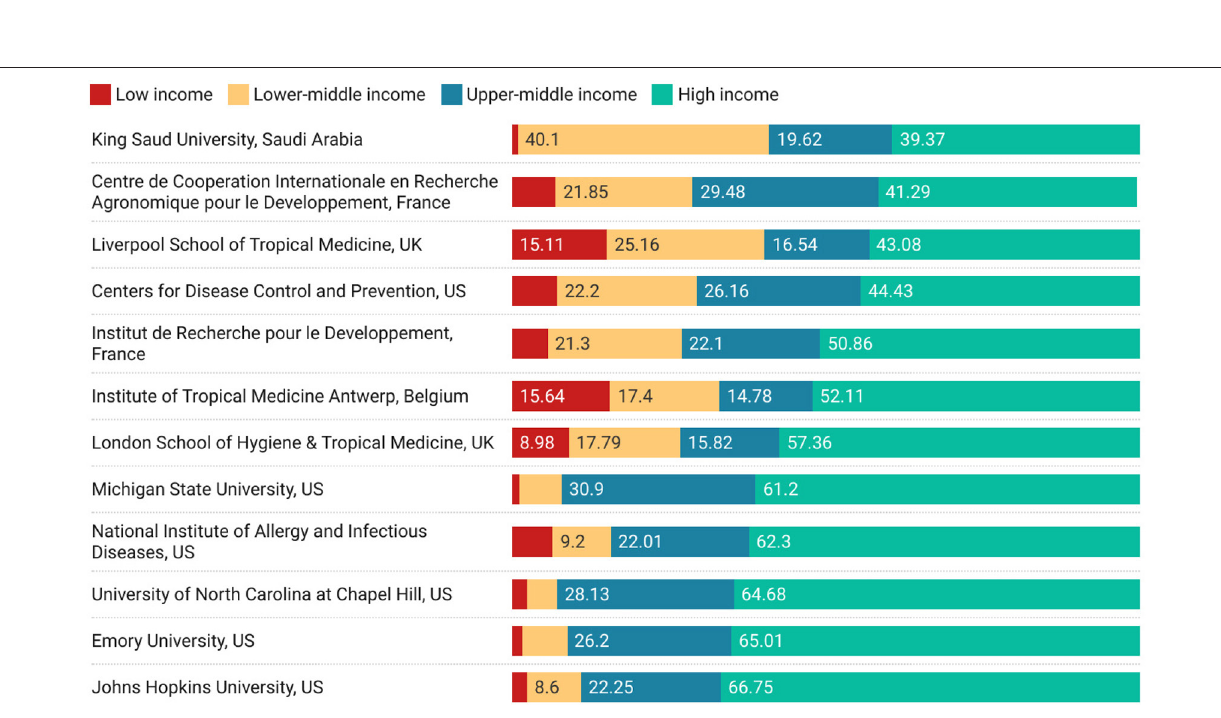
Frontiers in Research Metrics and Analytics |